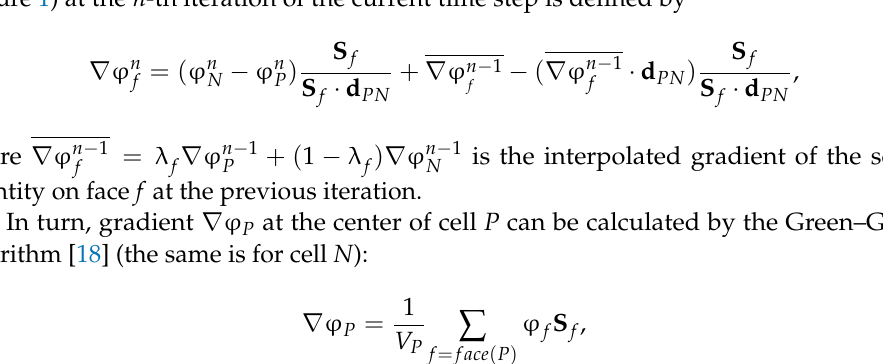
on interface face f of cell f